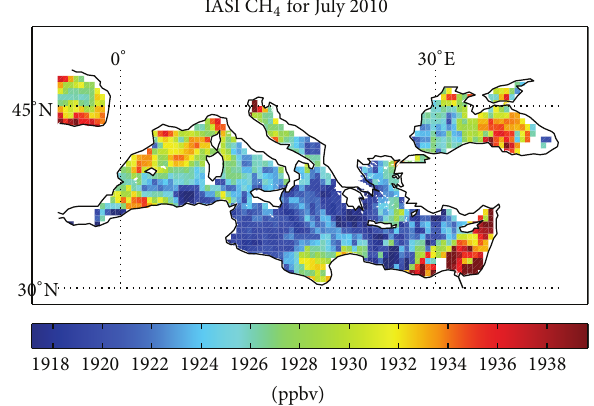
Figure 10: Retrieved tropospheric CH 4 O content for the month of July 2010. Data have been smoothed and rendered on a grid of 0.5 ∘ × 0.5 ∘ (lat. ×